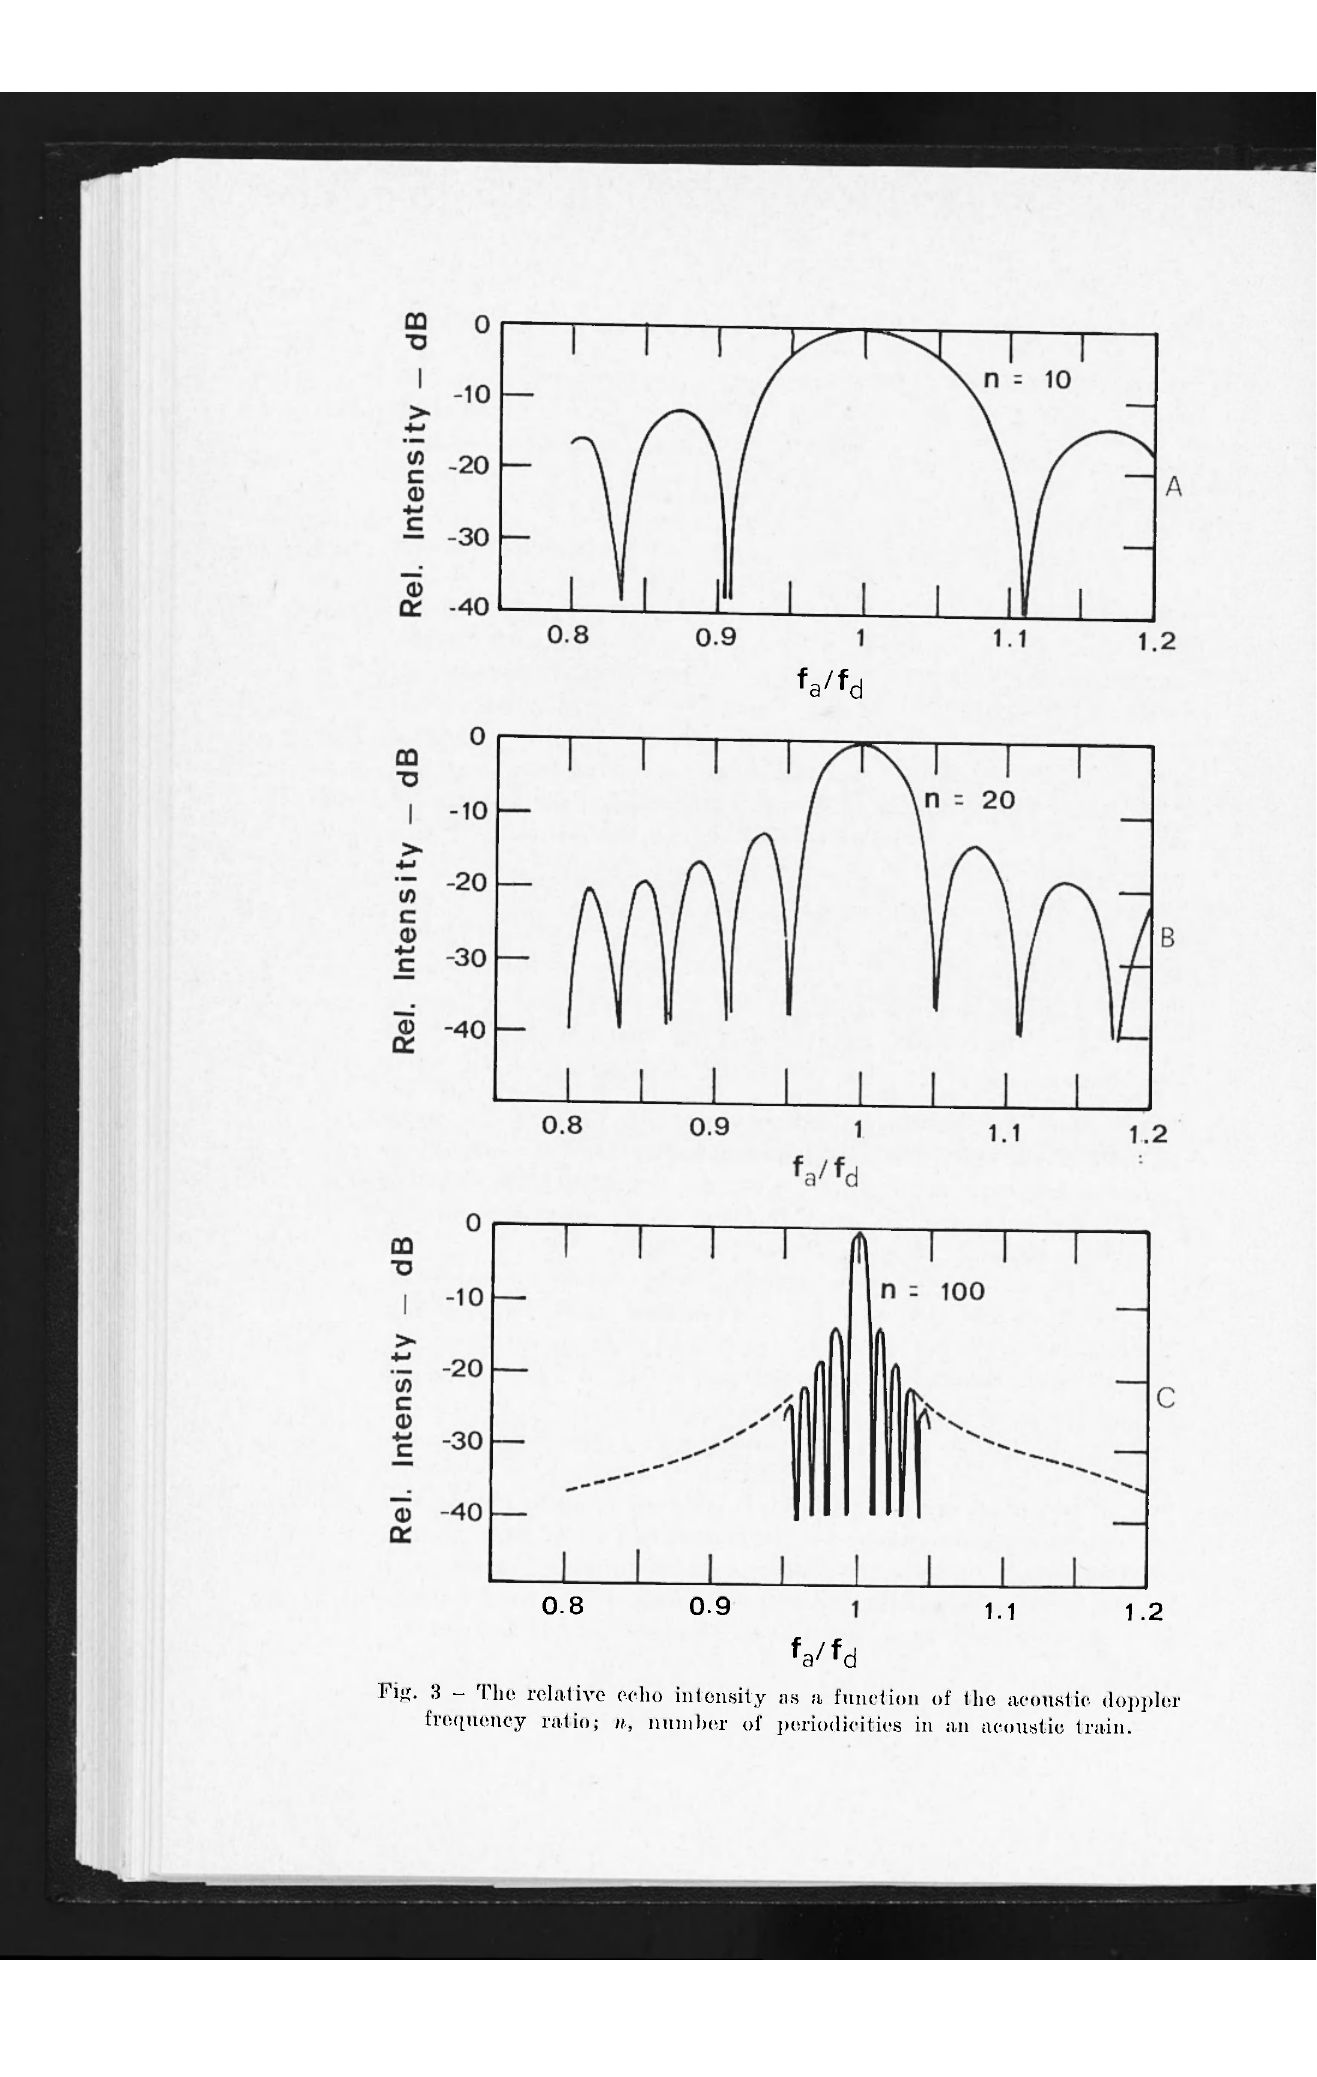
Fig. 3 - The relative echo intensity as a function of the acoustic doppler frequency ratio; n, number of periodicities in an acoustic